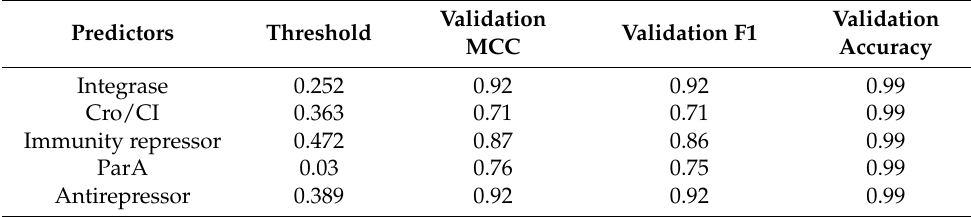
Figure 6. Test MCC of antirepressor predictor using original dataset and filtered datasets using different numbers of features. Graph on the right shows the magnified section of the original graph with MCC ranging from 0.5 to 1. Table 2. Optimized prediction threshold and validation score metrics of each